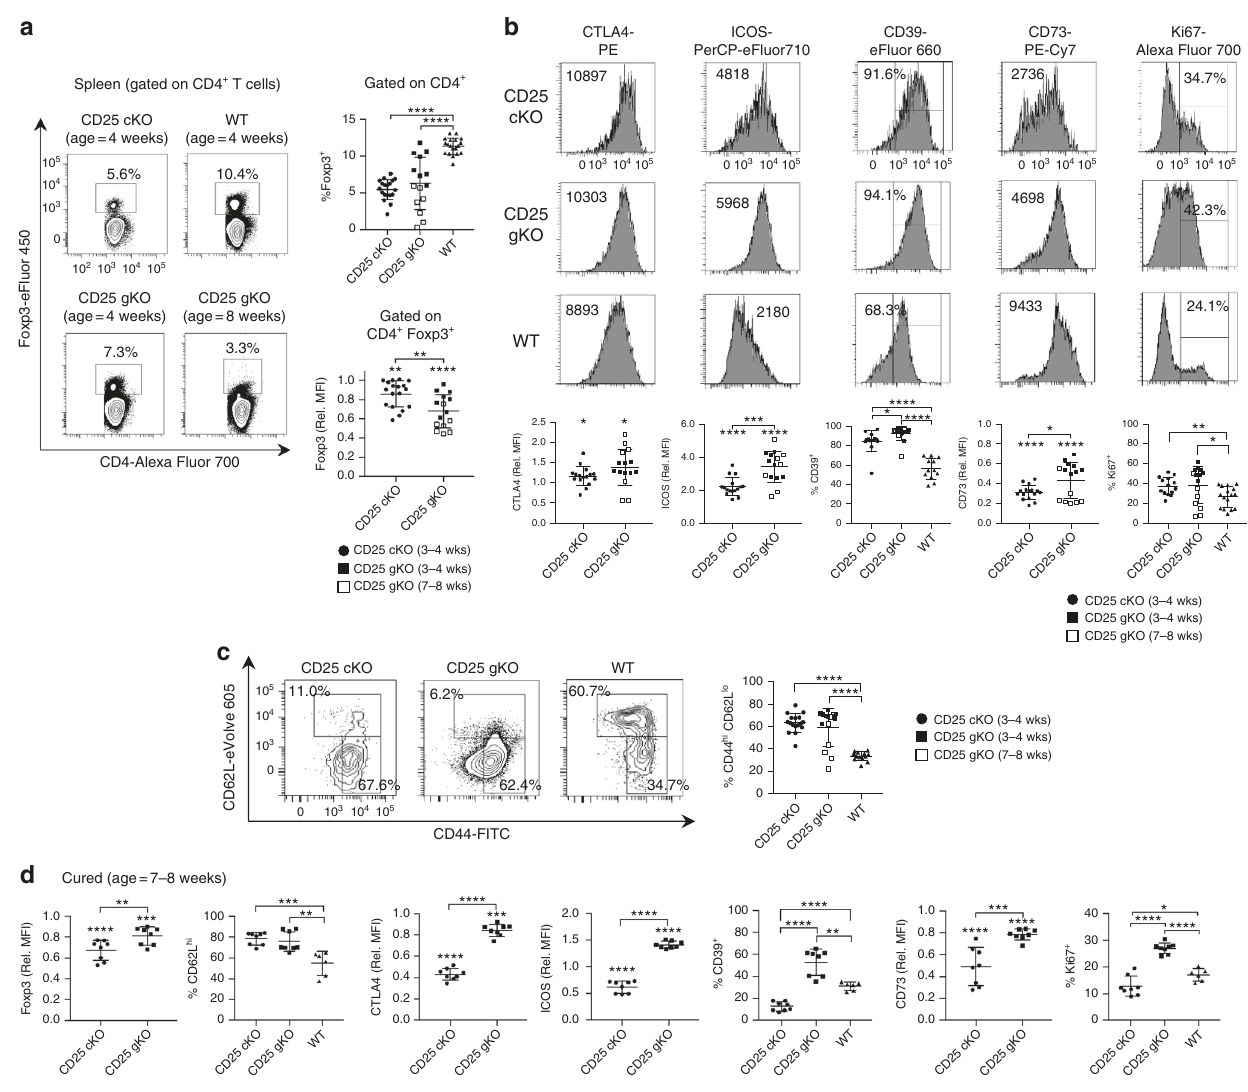
Fig. 4 Splenic CD4 + Foxp3 + T cells from CD25 cKO and CD25 gKO mice are skewed toward eTregs. a Representative contour plots (left) showing Foxp3 expression and gating strategy in splenic CD4 + T cells, with scatter plots (right) displaying Foxp3 expression as a proportion of total splenic CD4 + T cells and by mean fl uorescence intensity (MFI) at the speci fi ed ages ( n = 7 – 19 mice per group). b The indicated markers were evaluated in splenic CD4 + Foxp3 + T cells from CD25 cKO , CD25 gKO , and WT mice at the speci fi ed ages by ex vivo fl ow cytometry. Representative histograms (upper panels) and scatter plots (lower panels) are shown ( n = 7 – 16 mice per group). c Representative contour plots (left) and scatter plot (right) showing the proportion of splenic CD4 + Foxp3 + T cells with a CD44 hi CD62L lo eTreg phenotype in CD25 cKO , CD25 gKO , and WT mice at the speci fi ed ages ( n = 7 – 17 mice per group). d Scatter plots showing expression of the indicated markers for host-derived splenic CD4 + Foxp3 + T cells from ‘ cured ’ mice (age 7 – 8 weeks; n = 6 – 8 mice per group). Rel. MFI = relative MFI normalized to CD25 WT controls. Each symbol represents an individual mouse ( a , b , c , d ; mean ± SD). * p < 0.05; ** p < 0.01; *** p < 0.001; **** p < 0.0001. Symbols located directly above a single group of dots represent the comparison of that group against normalized WT control values (one sample t test); symbols located above brackets connecting two groups of dots represent inter-group comparisons (two-tailed Student ’ s t test). Data are representative of ( a , b , c ) or pooled from ( a , b , c , d ) three independent experiments Many pathways that overlapped between thymic and periph- promote development into functional suppressor cells specialized eral Tregs represent cytokine and Jak/STAT signaling, consistent to inhibit Th1 and Th2 responses. However, transcripts for with an expected common role for proximal IL-2R signaling in several effector cytokines ( Ifng , Il4 , and Il10 ) were increased in Tregs. Several other shared pathways (tetrahydrofolate salvage CD25-de fi cient peripheral Tregs (Supplementary Fig. 7). One from 5,10 methenyltetrahydrofolate, folate polyglutamylation, surprising result in the analysis of Th1 and Th2 pathway and superpathway of serine and glycine biosynthesis) indicate a constituents is that many were differentially expressed in opposite role for IL-2R signaling in amino acid and nucleotide biosynth- directions, suggesting that the IL-2 gene signature differs for esis. Th1 and Th2 pathways were also identi fi ed as IL-2R- thymic versus peripheral Tregs. However, we cannot exclude the dependent in both Treg compartments (Fig. 6g). For the thymus, possibility that these differences simply re fl ect the fact that, in the IL-2R-dependent genes identi fi ed in these pathways did not absence of IL-2R signaling, thymic Tregs are skewed toward a include Th1 or Th2 cytokines, but rather several transcriptional cTreg phenotype (Fig. 2f) whereas peripheral Tregs are skewed regulators and immunological mediators that might act to toward an eTreg phenotype (see below). NATURE COMMUNICATIONS| (2019) 10:1037